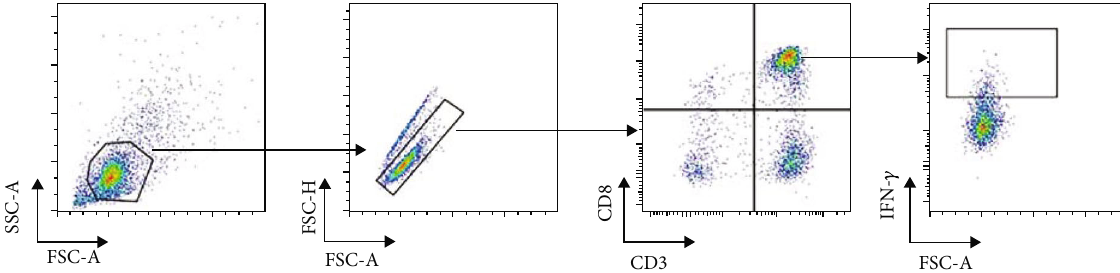
Figure 1: Cell shooting of fl ow cytometry.